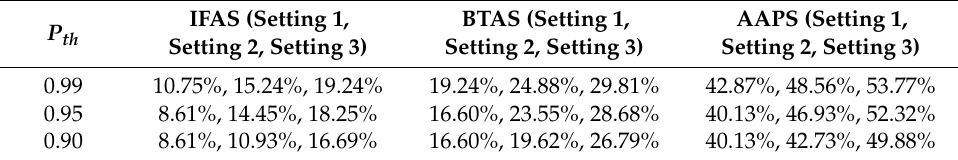
Figure 20. The average delay with P th as variable (setting 1, setting 2, setting 3). Table 11. The improvement of delay compared with the traditional algorithm.